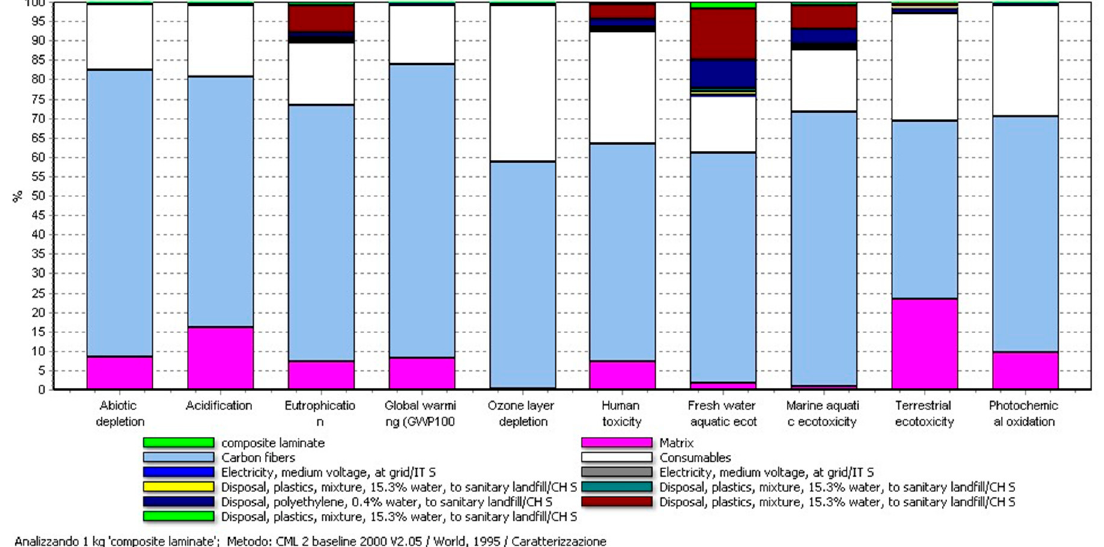
Figure 6. Impacts associated with the production of the CF composite laminate, method CML2000. For all the impact categories, the main contributions derive from the use of CFs, the matrix (epoxy resin + Recyclamine ® ), and the consumables required for the VRTM process.